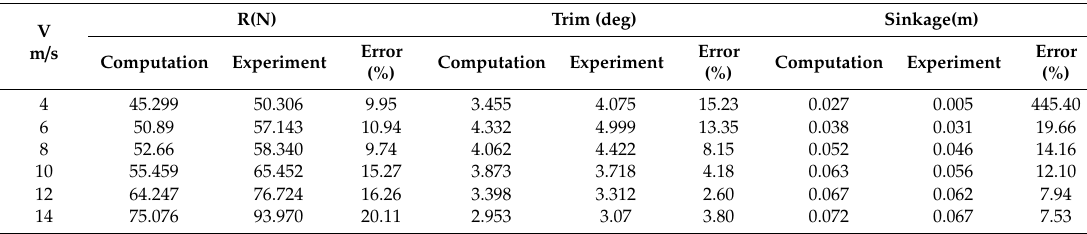
Table 2. Computational result and experimental